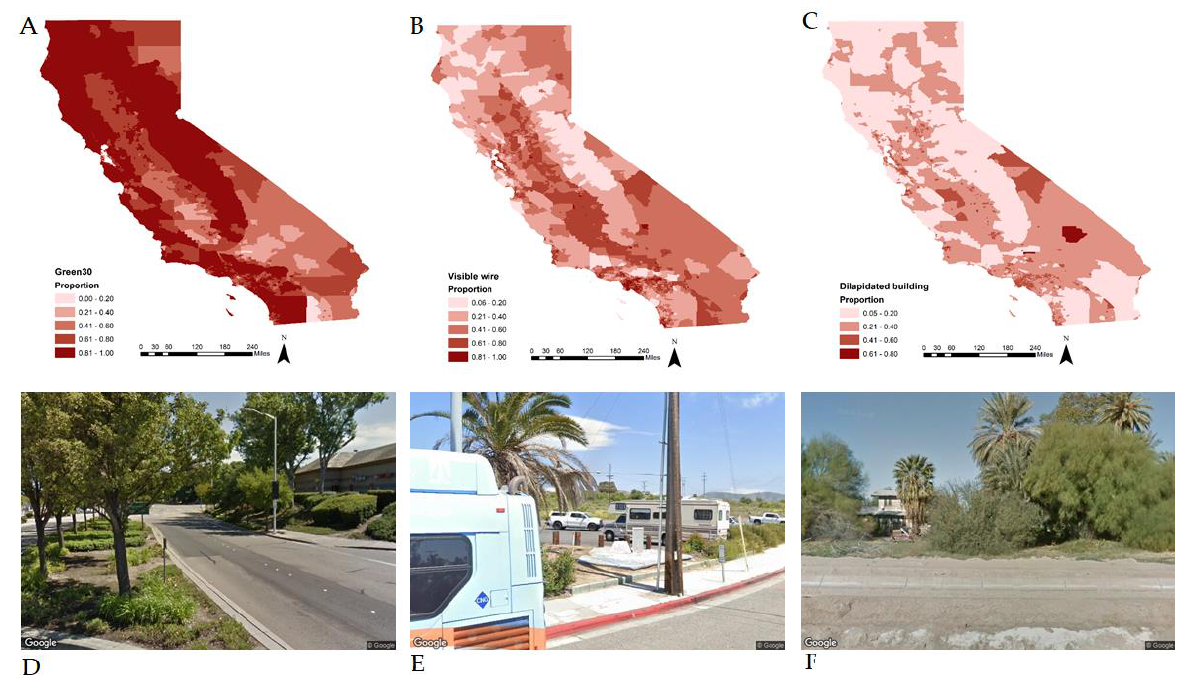
Figure 1. Spatial distribution of Google Street View (GSV)-derived built environment characteristics across census tracts in California. For each census tract, the following was calculated: percentage of GSV images with ( A ) Green30—street landscaping comprising at least 30% of the image; ( B ) visible utility wires overhead; and ( C ) dilapidated buildings. Census tract characteristics were spatially mapped and darker colors represent higher values. Below the maps, sample GSV images are presented. The left panel gives an example of a green street ( D ), the second panel gives an example of visible utility wires ( E ), and the third panel gives an example of dilapidated buildings ( F ). Data source: Google Street View images. Table 2. Associations between Google Street View-derived built environment characteristics and coronary artery disease, hypertension, and diabetes (N = 214,163).